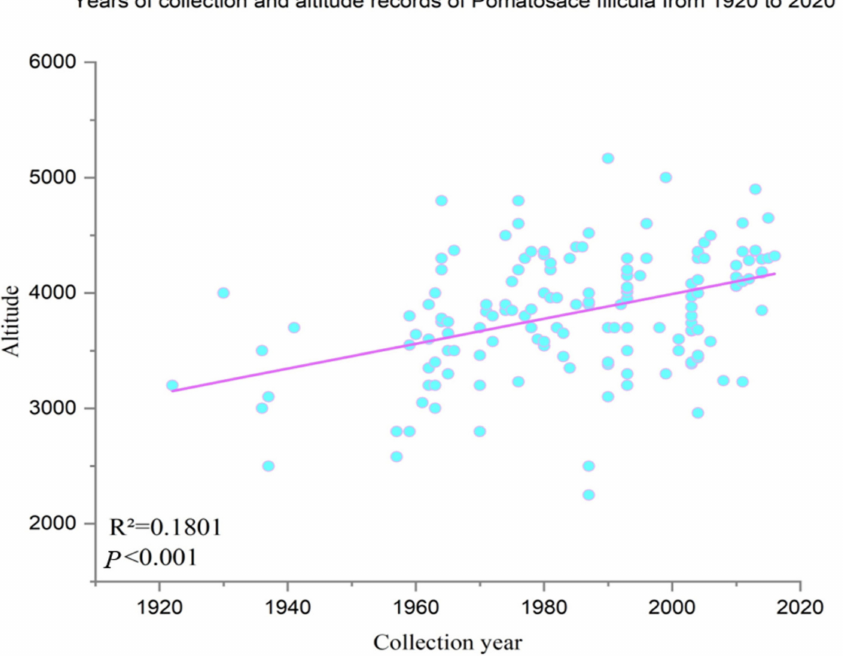
Figure 7. Statistical year and elevation of P. filicula collected in 1920–2020. The blue dots represent the year in which the P. filicula were collected and the corresponding elevation; the blue dashed line represents the trend line of the elevation at which P. filicula was collected with increasing